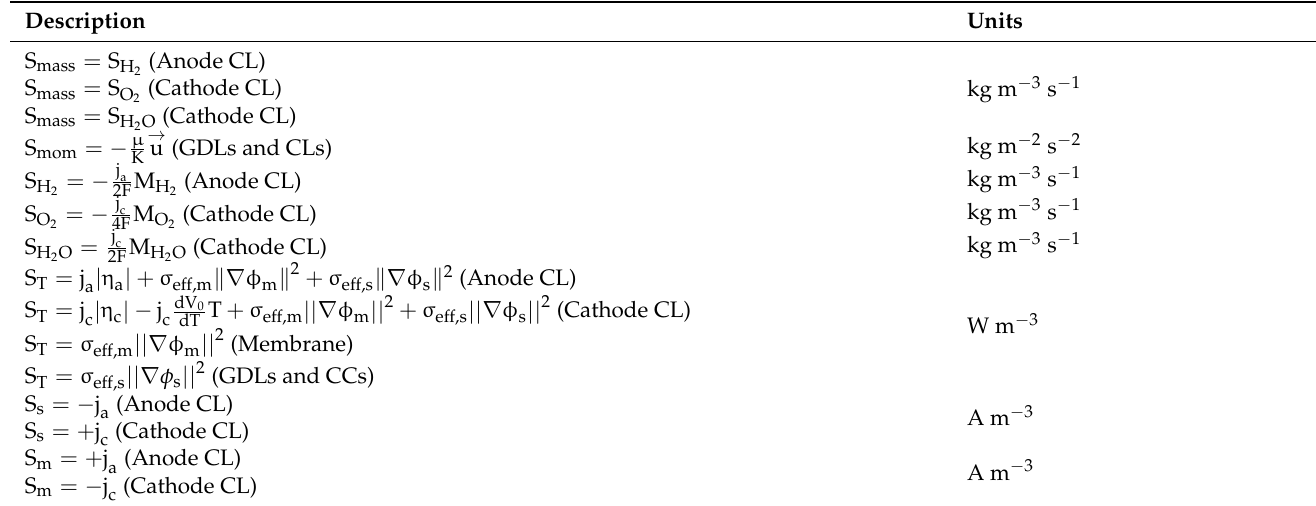
Table 2. Source terms of the governing equations.